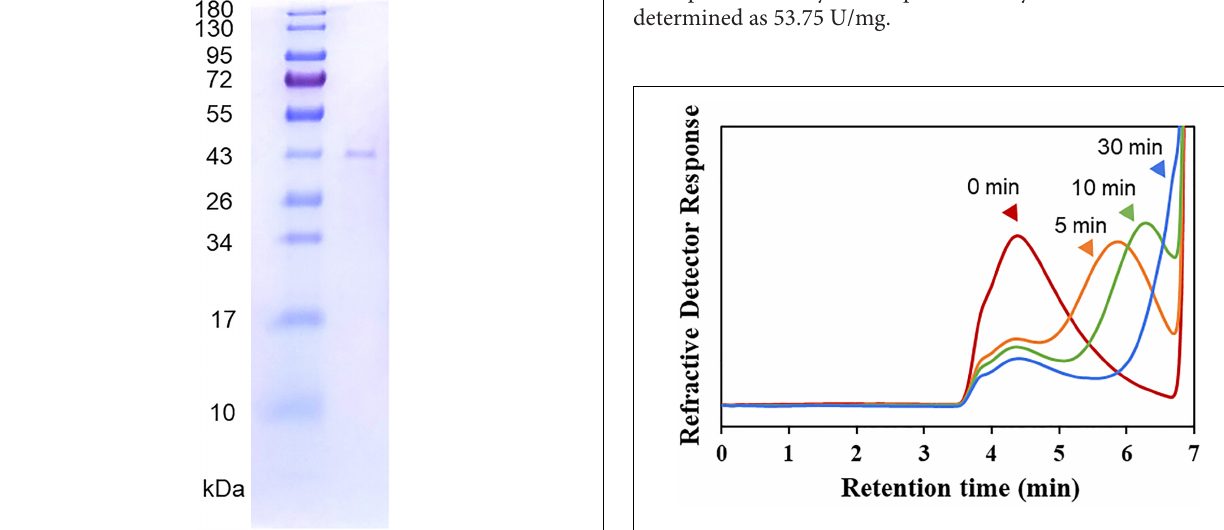
FIGURE 2 | SDS-PAGE of the purified recombinant Cgbk16A_Wf.